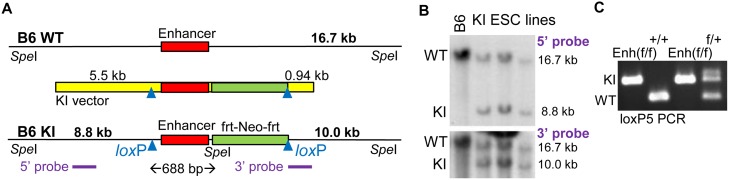
Generation of B6 Mice with Floxed Cebpa +37 kb Enhancer Alleles.A) Diagram of a wild-type genomic allele in the vicinity of the +37 kb Cebpa enhancer (B6 WT), the knockin (KI) vector, and a targeted genomic allele (B6 KI). The conserved 439 bp enhancer is flanked by a frt-PGK-Neo-frt cassette and two loxP sites. Cre-mediated deletion of the DNA between the loxP sites will remove the enhancer, 214 bp of DNA 5’ to the enhancer, and 35 bp of DNA 3’ to the enhancer, 688 bp in total. Positions of SpeI sites, fragment sizes expected after SpeI digestion, and locations of the 5’ and 3’ probes used for Southern blotting are also shown. B) Southern blots obtained after SpeI digestion of genomic DNA isolated from parental B6 BL-1 ESC (B6) or from three targeted lines (KI ESC lines) using the 5’ or 3’ probes. Locations and sizes of fragments derived from the WT and KI alleles are indicated. C) PCR of tail snip DNA, using loxP5 primers spanning the 5’ loxP site, from homozygous Enh(f/f), WT (+/+), and heterozygous (f/+) mice obtained after breeding. Locations of bands obtained from the KI and WT alleles are indicated.